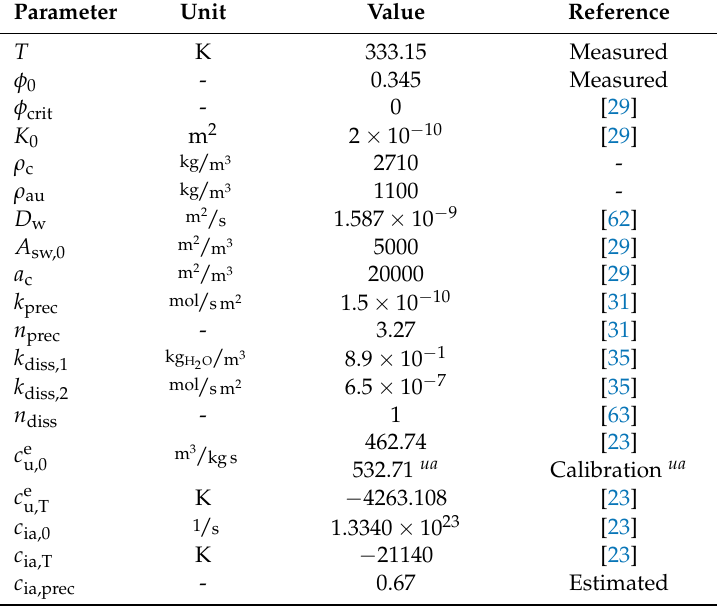
Table A4. Model parameter values used and calibrated for the presented EICP